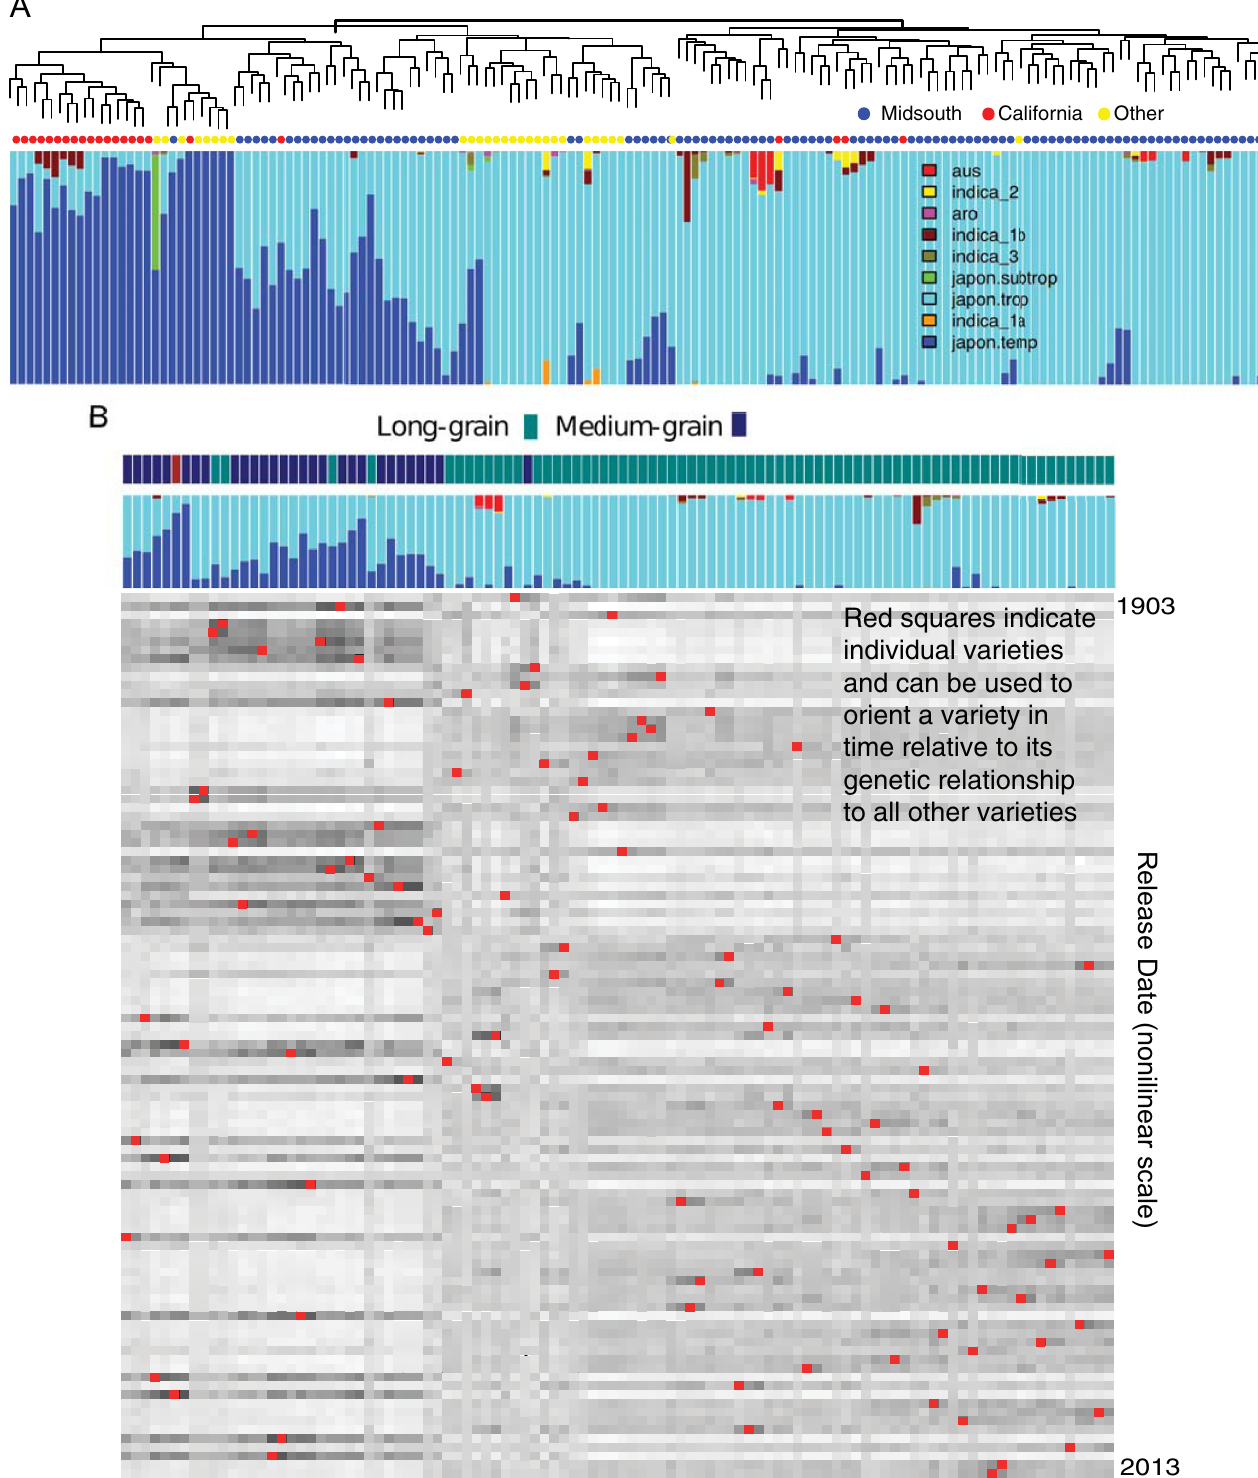
Fig 3. The genetic structure of US rice breeding varieties. A) The population structure of sequenced US germplasm samples in this study. The dendrogram represents hierarchical clustering based on a kinship matrix derived from the low LD marker set (See Materials and Methods). Bar plots, based on the same markers, indicate the proportion of genetic content of each individual that can be assigned to a set of known rice subpopulations. Colored dots represent